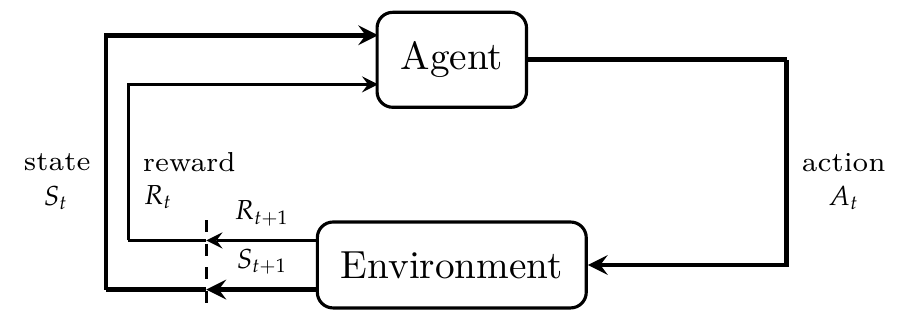
Figure 1. Agent–environment interface